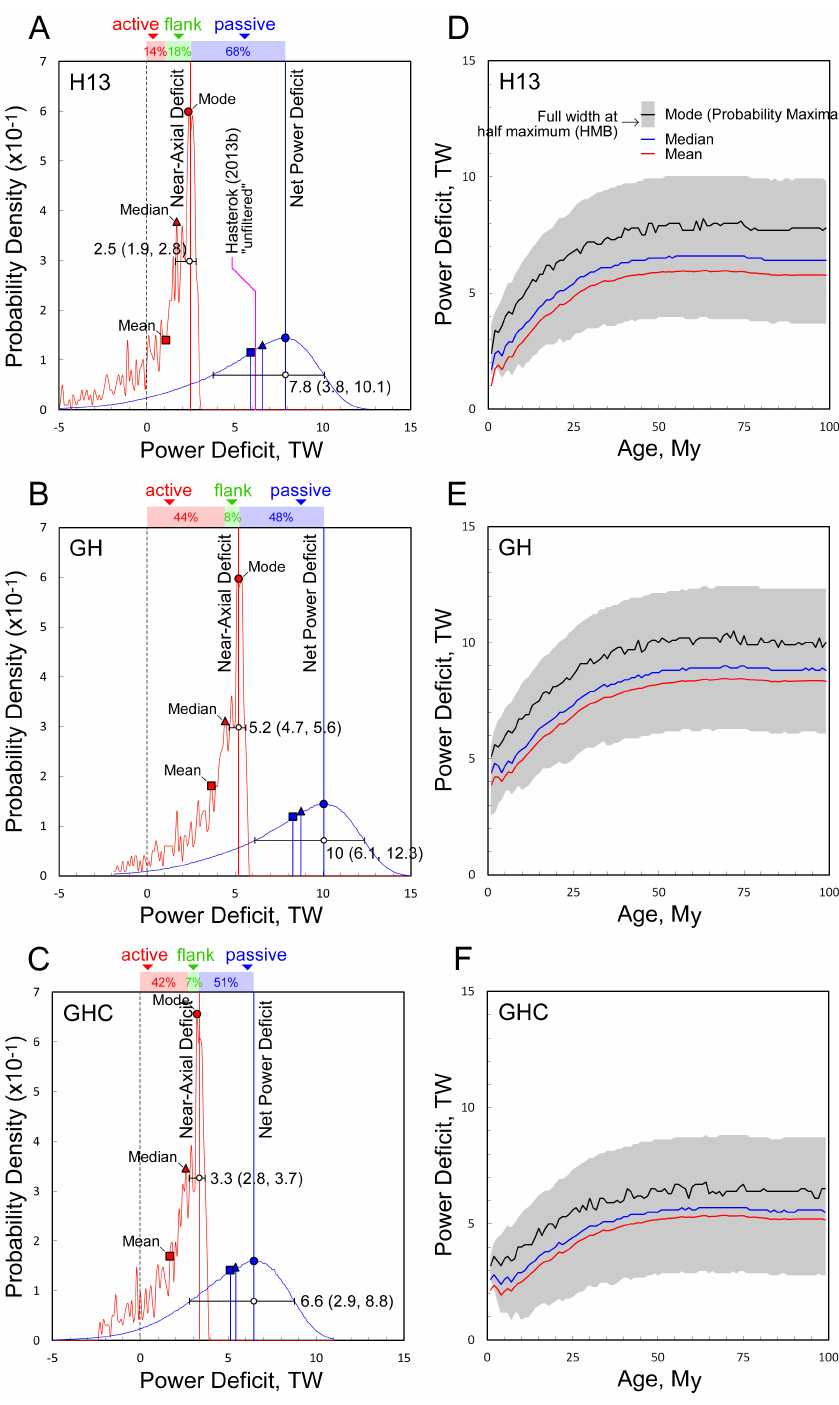
Figure 4. Probability density functions of the heat flow deficit determined from Monte Carlo analysis for models (a) H13 (Hasterok 2013a), (b) GH, and (c) GHC (Grose and Afonso, 2013). The red PDF (left panels) represents numerical integration only within the first 1My bin (near-axial power deficit), and the blue PDF is the heat flow deficit integrated to 60My (net power deficit). The filled circles, triangles, and squares indicate the mode, median, and mean of the PDFs, respectively. The white filled circles with error bars indicate the mode and half-maximum bounds for the 1My (near-axial power deficit) and 60My (net power deficit) PDFs. The red, green, and blue bars above the graphs (left panels) indicate the fraction of active, flank, and passive advective power, respectively. Hasterok’s (2013b) “unfiltered” estimate is indicated in panel (a) . The right-side panels show the mean, median, mode, and half-maximum uncertainty of the power deficit as a function of age for each